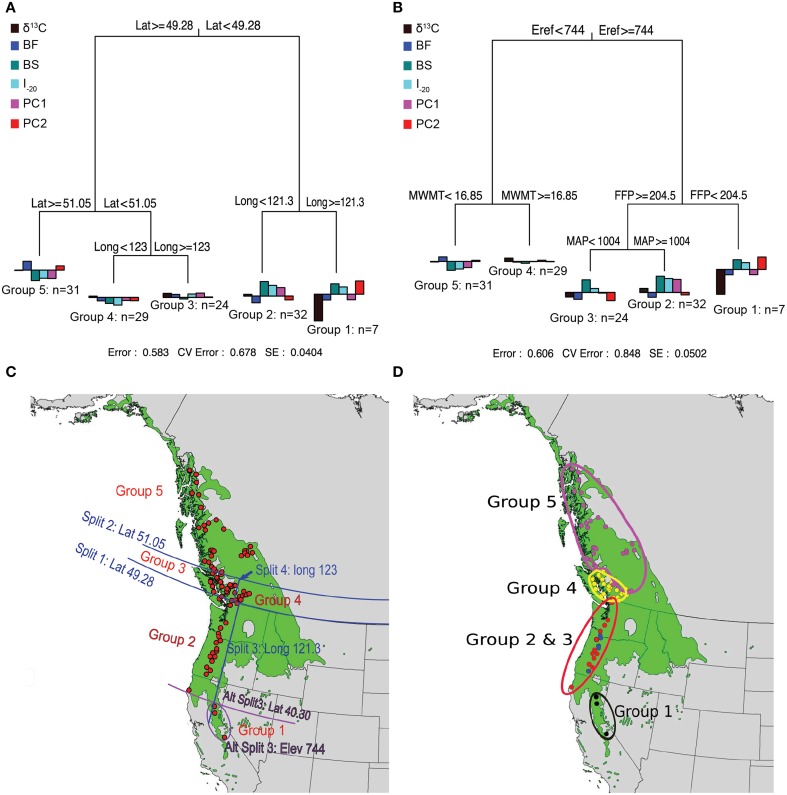
Multivariate regression tree (MRT) analyses of the 124 black cottonwood genotypes with latitude, longitude and altitude as predictor variables (A); with climate as predictor variables (B); and geographic representation of the splits (C,D). Bar charts at the terminal leaves of the regression trees represent population means for the traits.